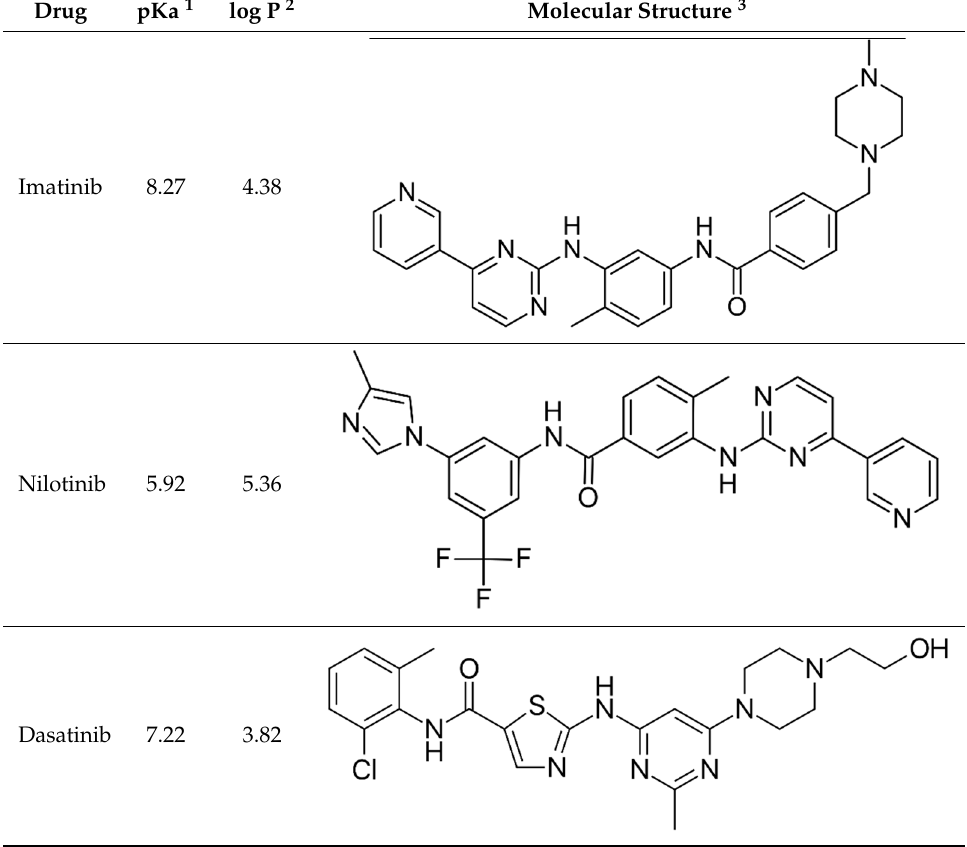
Table 1. Molecular structure and physicochemical properties of the TKIs studied.